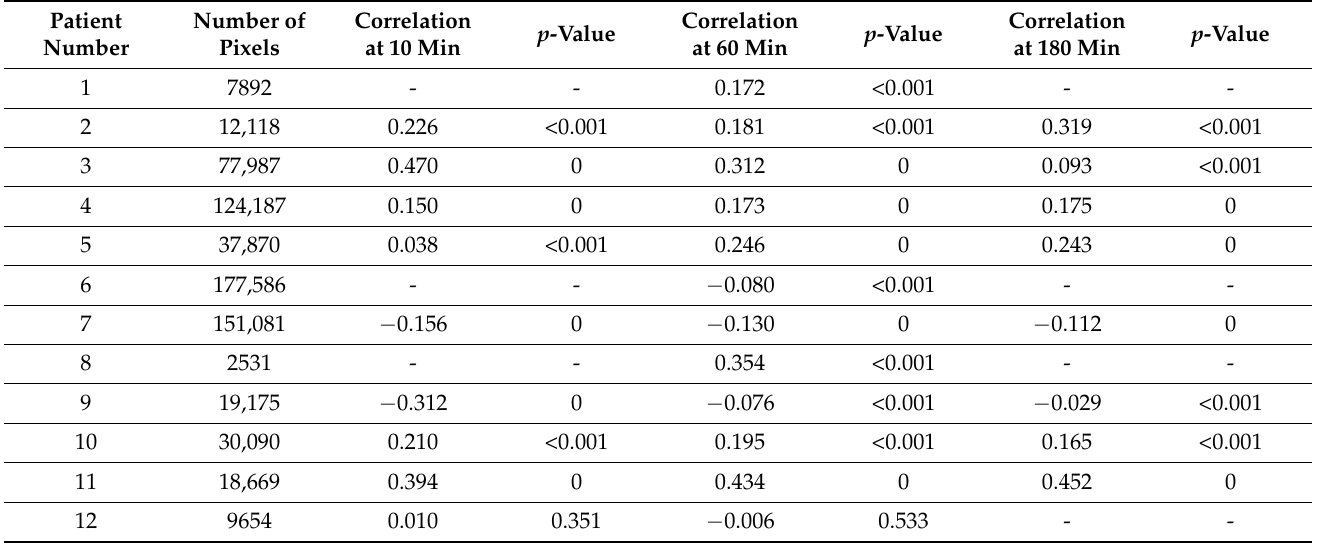
Table 3. Correlation results of 68Ga-FAPI uptake and ceT1w MRI signal.